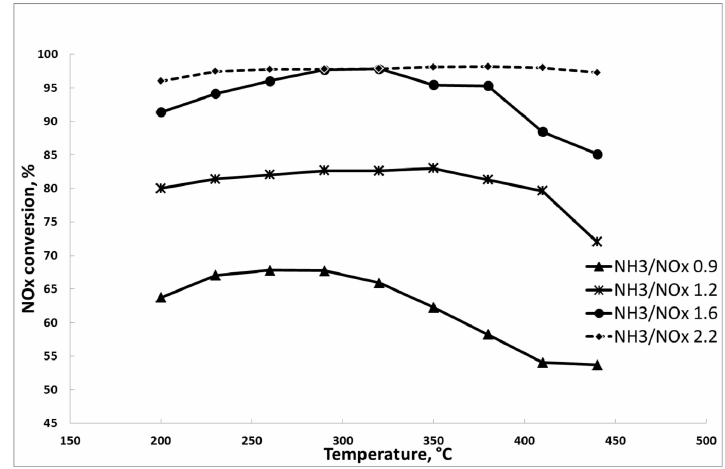
Figure 2. Effect of the temperature on NOx conversion at different NH 3 /NOx ratios for Fe-ZSM-5 catalysts.